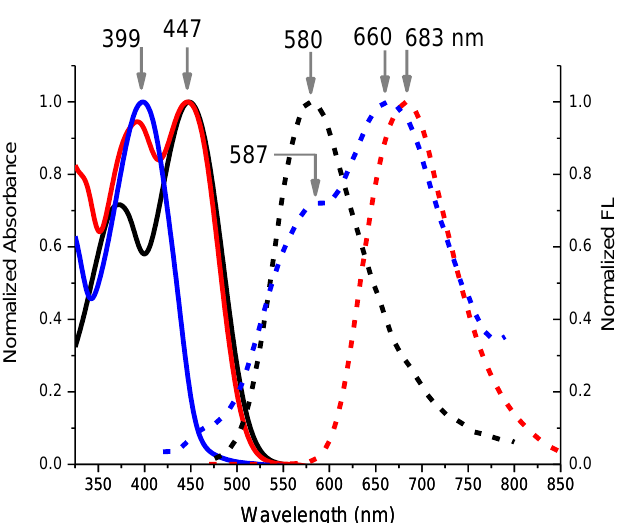
Figure 3. UV – vis absorption (solid line) and emission spectra (broken line) of compound 3 (red), 5 (black) and 6 (blue) in CH 2 Cl 2 (10 μM). The excitation wavelengths were 447 nm for 3 and 5 , and 399 nm for 6 , respectively; fluorescence spectroscopy (FL).